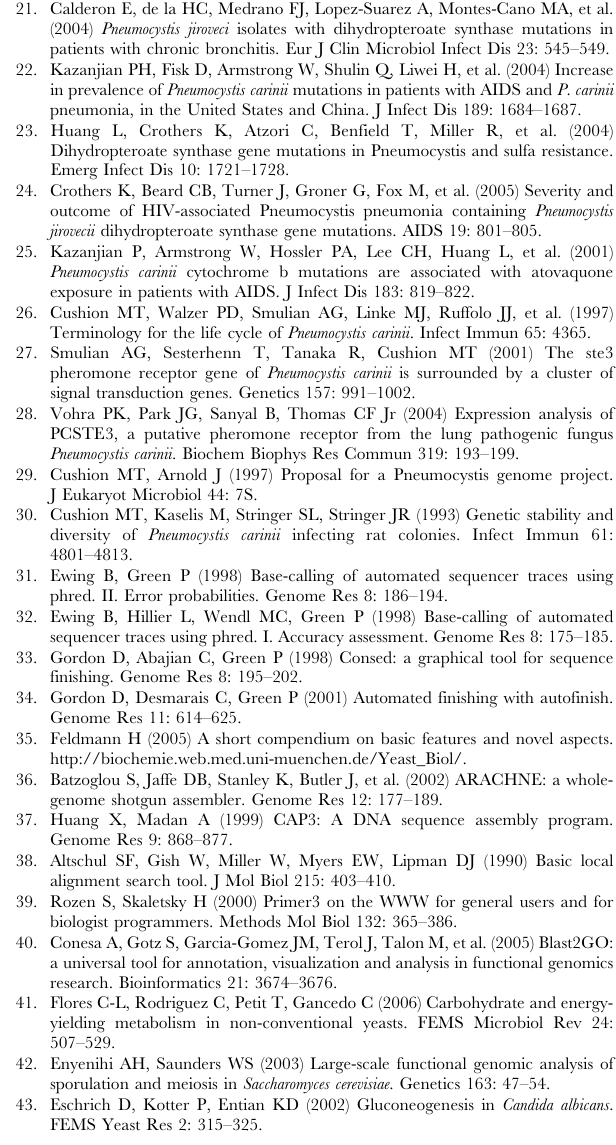
Table S3 EST BLAST2GO Cellular Compartmentalization Assignments-All levels. Hierarchical distribution of the cellular compartmentalization assignments of the ESTs by BLAST2GO.